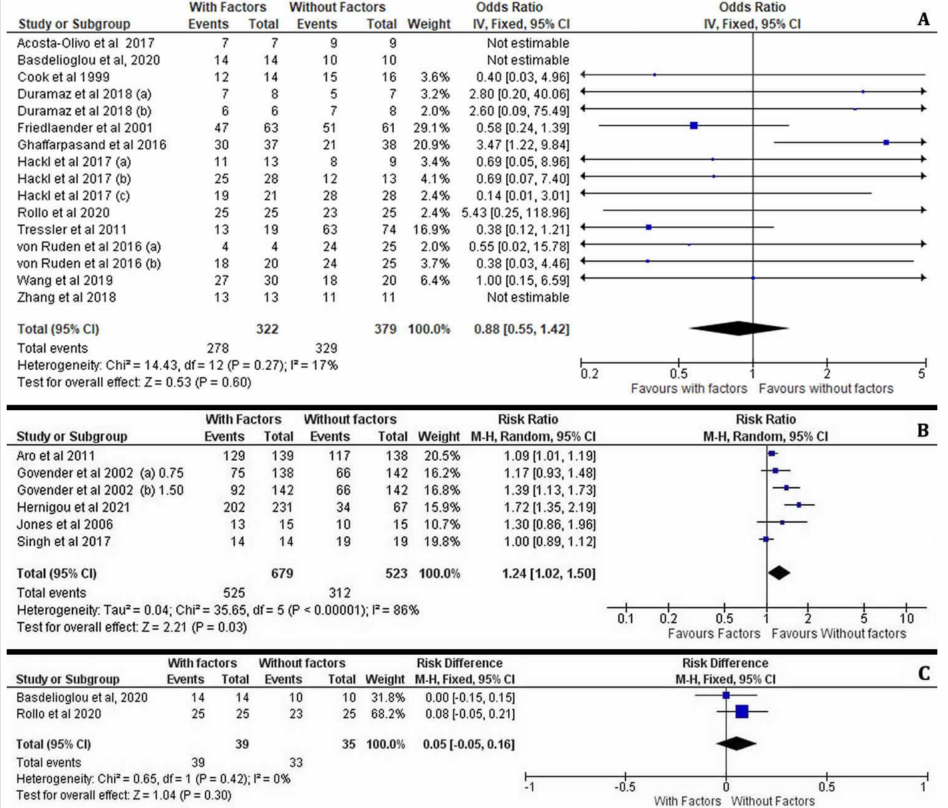
Figure 5. Forest plots showing the effectiveness of osteoinductive factors ( A ) on non-unions, ( B ) open and ( C ) close fractures compared to the control group of patients who have not received additional factors at the fracture site